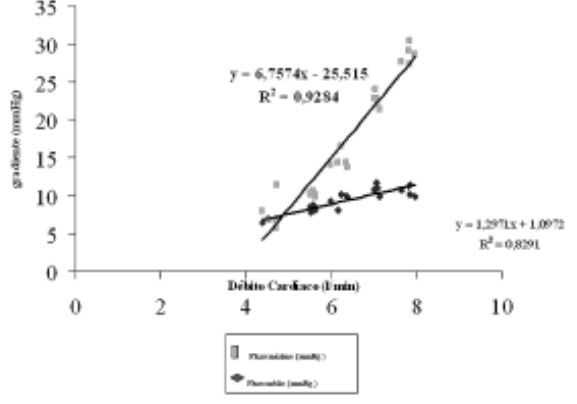
Fig. 3 – Análise do gradiente pressórico